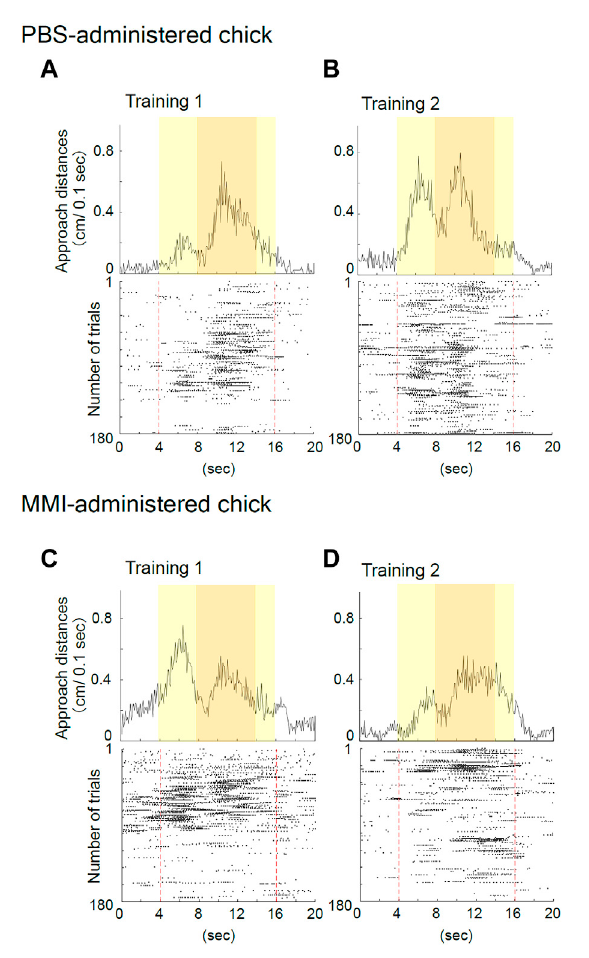
FIGURE 3 Representative behavior of phosphate-buffered saline (PBS)- administered and methimazole (MMI)-administered chicks during imprinting training. (A) Averaged approach distances (upper column) and raster plots (lower column) for each trial in Training one of the PBS-administered chick are shown. In the raster plots, one plot indicates the timing of a 1/10 turn of the disc, and the broken red line indicates the onset and offset of the object presentation. The PBS- administered chick responded to the object when it was moving and made a sound during Training 1. (B) The PBS-administered chick responded to both the moving and static imprinting object during Training 2. (C) The MMI-administered chick responded to the imprinting object during Training one similar to the PBS-administered chicks. (D) TheMMI-administeredchick ’ sresponsesdecreasedforthe imprinting object during Training